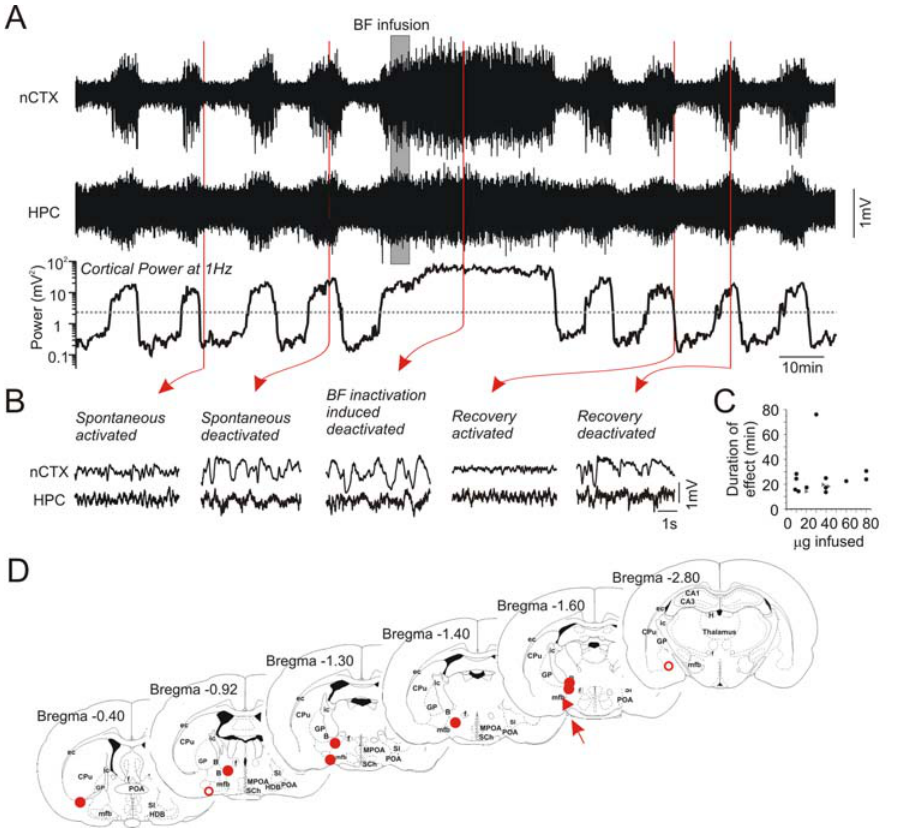
Figure 10. Local pharmacological inactivation of the basal forebrain region reversibly induces a deactivated state and temporarily abolishes state alternations. A) Continuous long duration cortical and hippocampal EEG traces together with spectrographic cortical power at 1 Hz during an infusion of lidocaine in the basal forebrain (BF). Spontaneous state alternations were temporarily abolished in favor of a continuous activated state following inactivation of the BF. B) Expanded EEG traces from neocortical and hippocampal sites prior and following the infusion. Deactivated patterns were elicited during inactivation of the BF and these effects washed out with time. C) Duration of evoked deactivated activity as a function of the amount of lidocaine infused in the BF. D) . Histological representation of infusion sites. Open circles indicate ineffective sites. Site marked with arrow and triangle denotes experiment shown in A and B. Abbreviations: B: basal nucleus, CPu: caudate putamen, ec: external capsule, f: fornix, GP: globus pallidus, HDB: horizontal limb of the diagonal band of Broca, ic: internal capsule, mfb: medial forebrain bundle, MPOA: medial preoptic area, POA: preoptic area, SCh: suprachiasmatic nucleus, SI: substantia innominata.